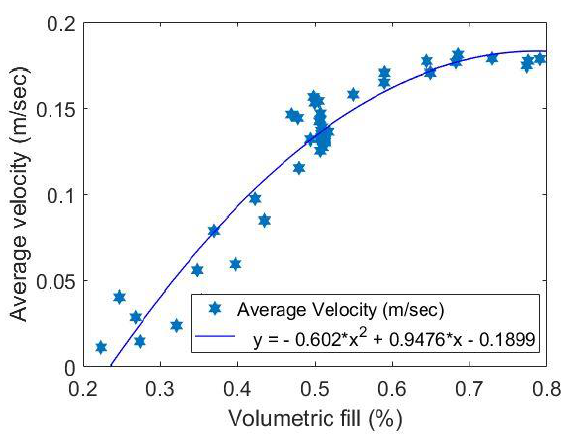
Fig. 6. Dependence of average velocity on volumetric